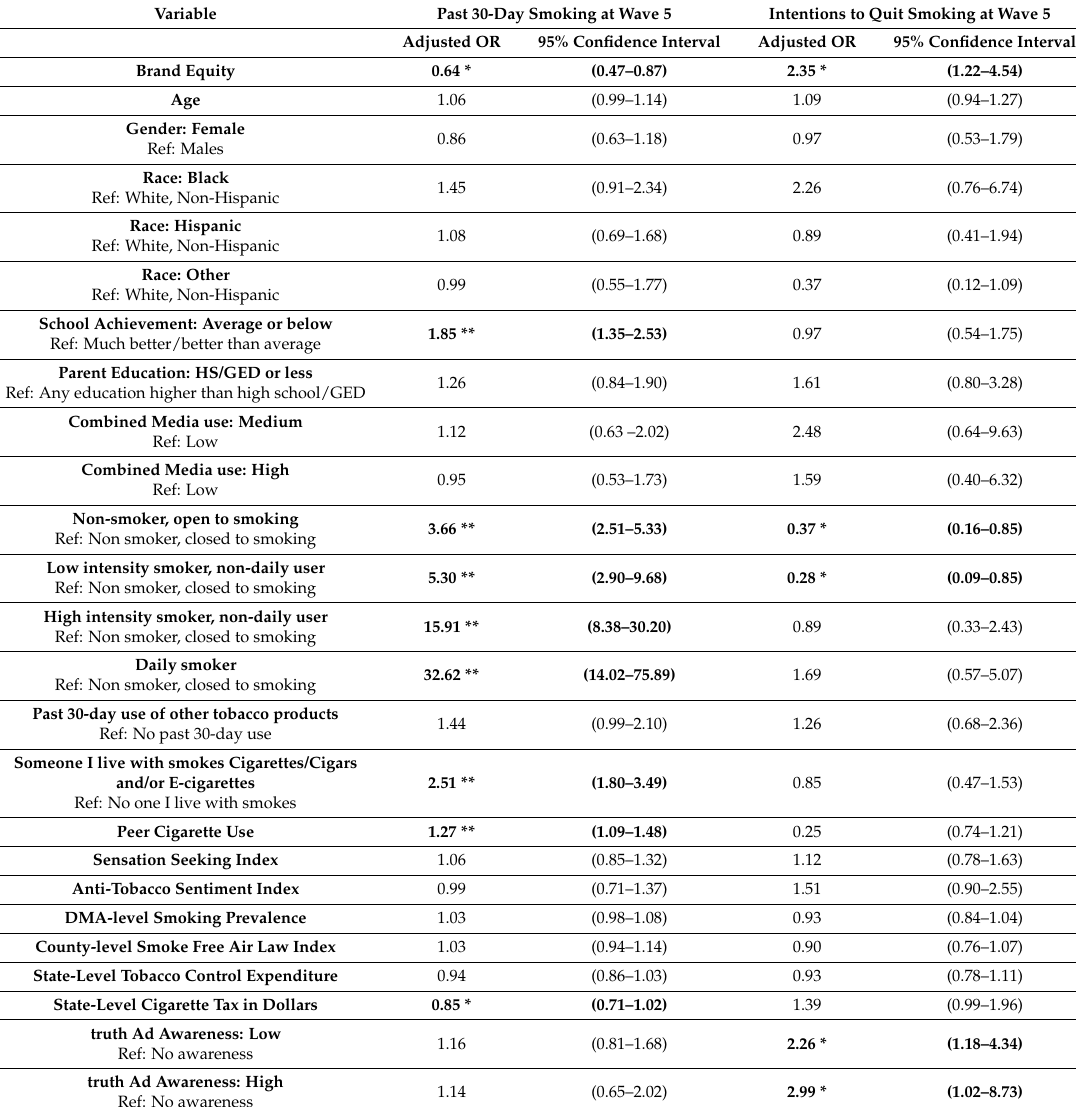
Table 3. Logistic regression models: Past 30-day smoking and Intention to quit smoking at wave